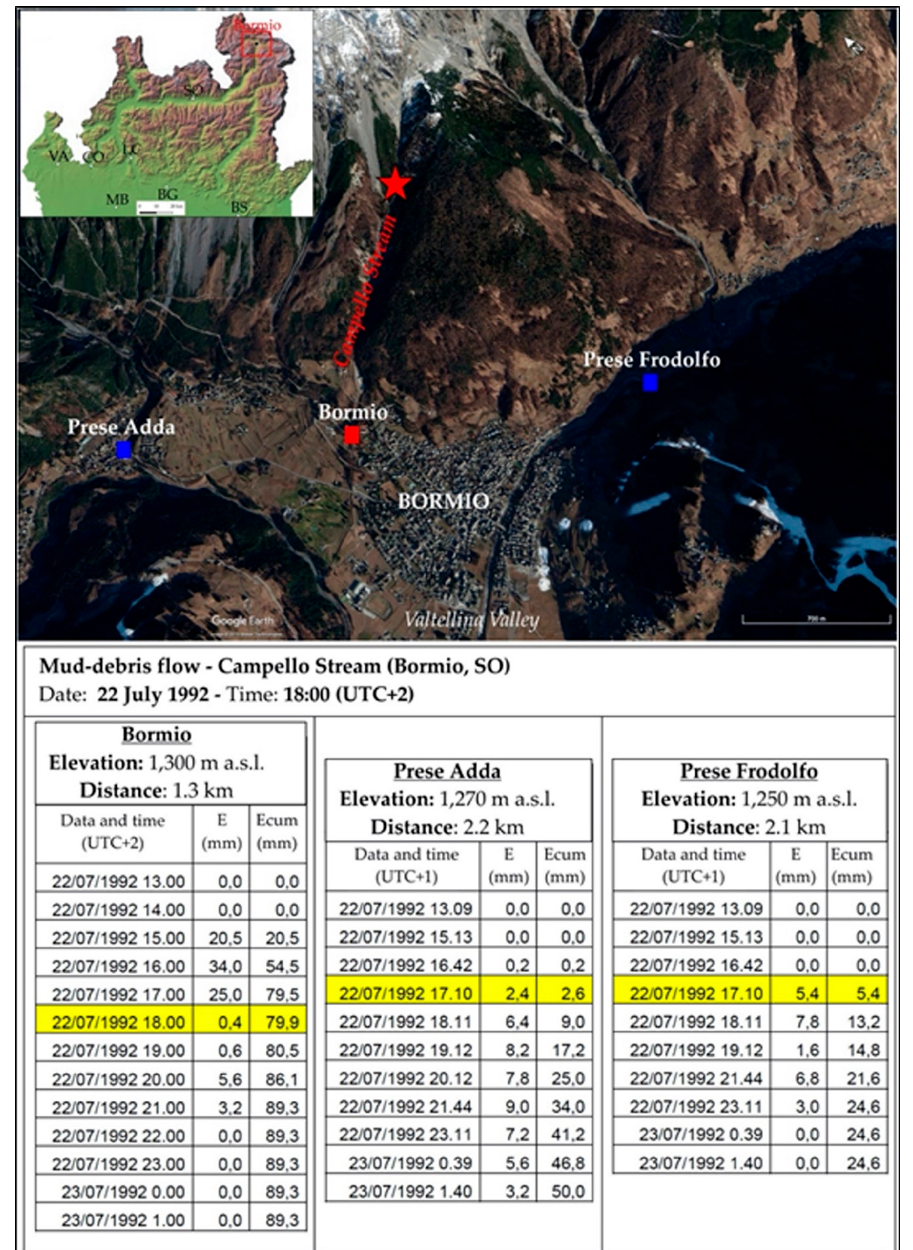
Figure 7. Example of variability in rainfall measurements during the short and very intense localized rainstorm that occurred on 22 July 1992 at Bormio ( SO ), which triggered a mud-debris flow along the Campello Stream valley [97]. The three rain gauges are located at similar altitude and distance from the slope failure but a few hundred meters lower than the triggering point and in di ff erent sub-catchment. Red star shows the triggering point of mud-debris flow. Squares represent the di ff erent type of rain gauge: mechanical ( red ) and automatic ( blue